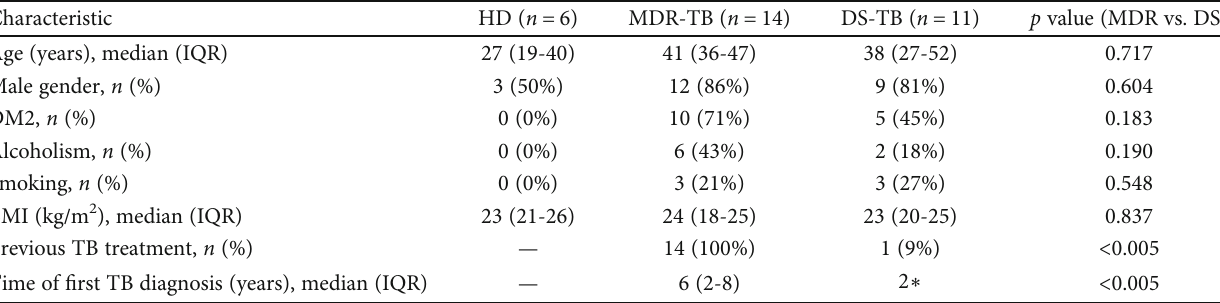
Table 1: Baseline characteristics of the study population.